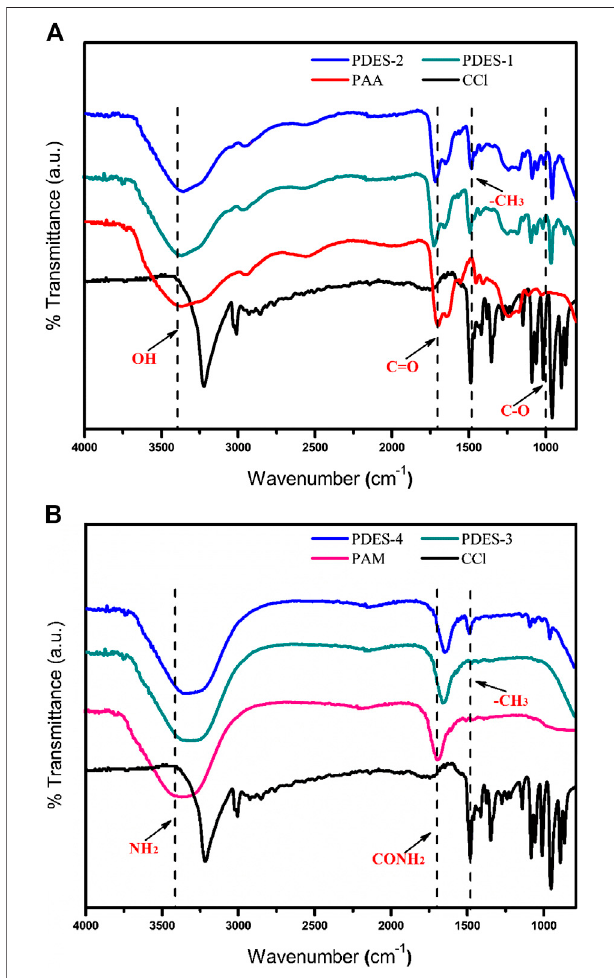
FIGURE 3 | (A) FTIR spectra of PAA based PDESs. (B) FTIR spectra of PAM based